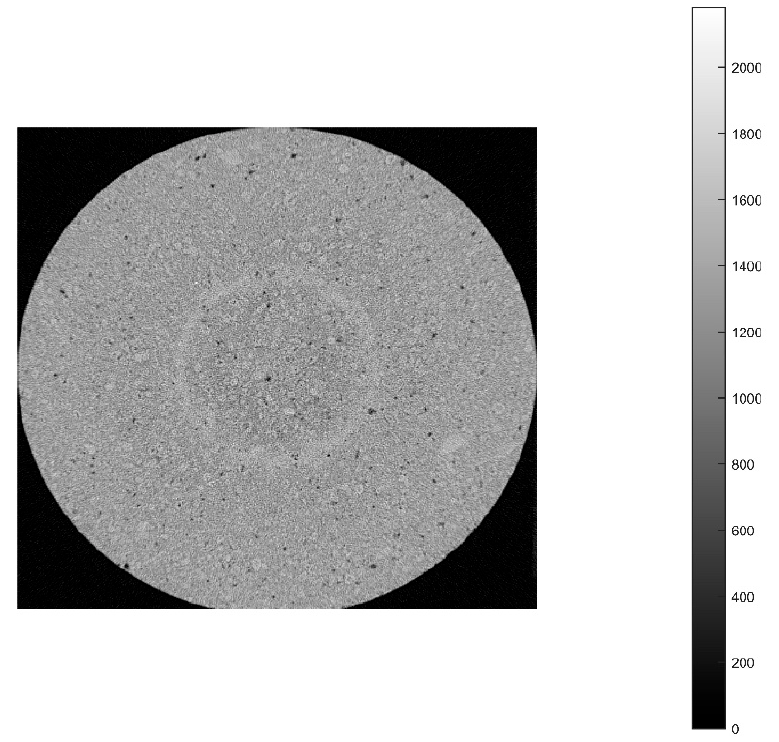
Figure 13. Density profile for a layer located few millimeters above the slot.